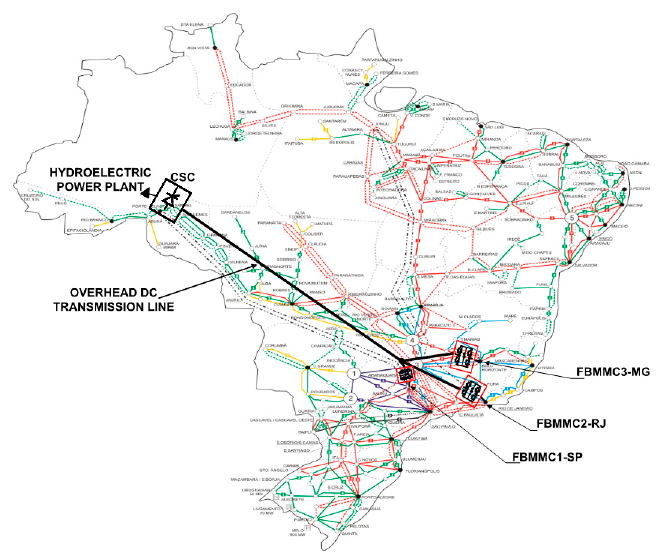
Figure 14. Hypothetical configuration of the H 2 VDC system for transmitting power from the Amazon region to the main load centers of Brazil with three FBMMC terminals (Rio de Janeiro, São Paulo and Minas Gerais).